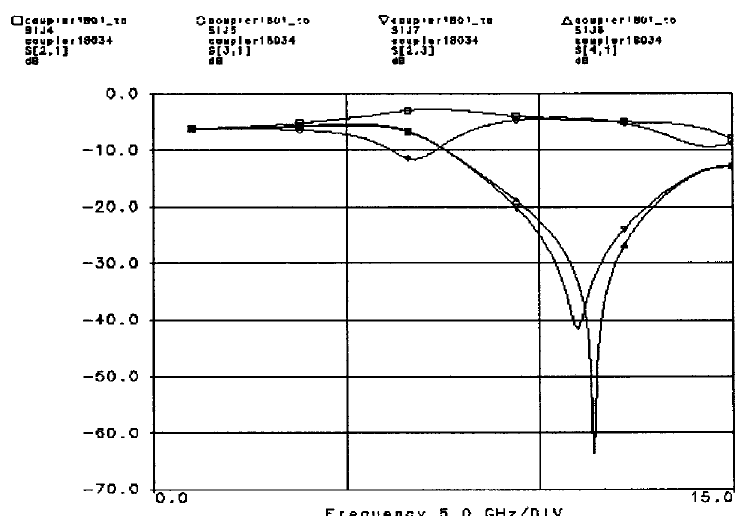
FIGURE 15 Transmission coefficients ( j s 21 j ; j s 31 j and j s 41 j ) and isolation ðj s 23 jÞ between the output